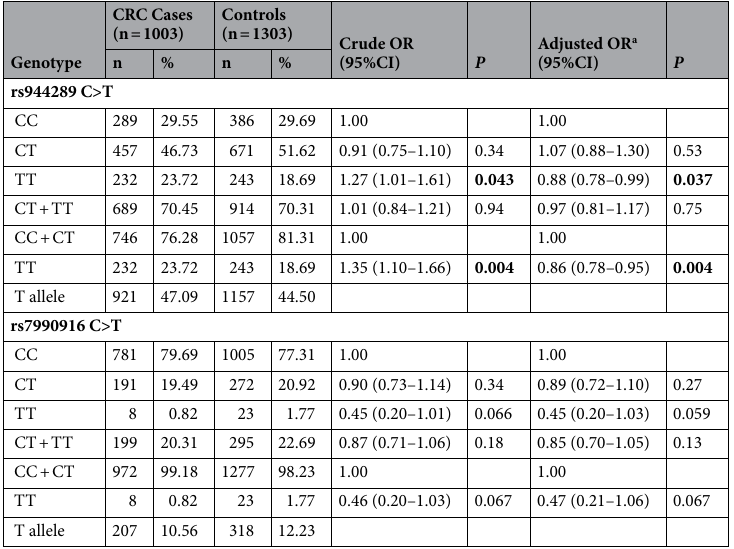
Table 3. Genotype Frequencies of LncRNA rs944289 C>T and rs7990916 C>T Polymorphisms and the CRC Risk. Bold values are statistically significant ( P < 0.05). a Adjusted for age, gender, smoking, alcohol use and BMI